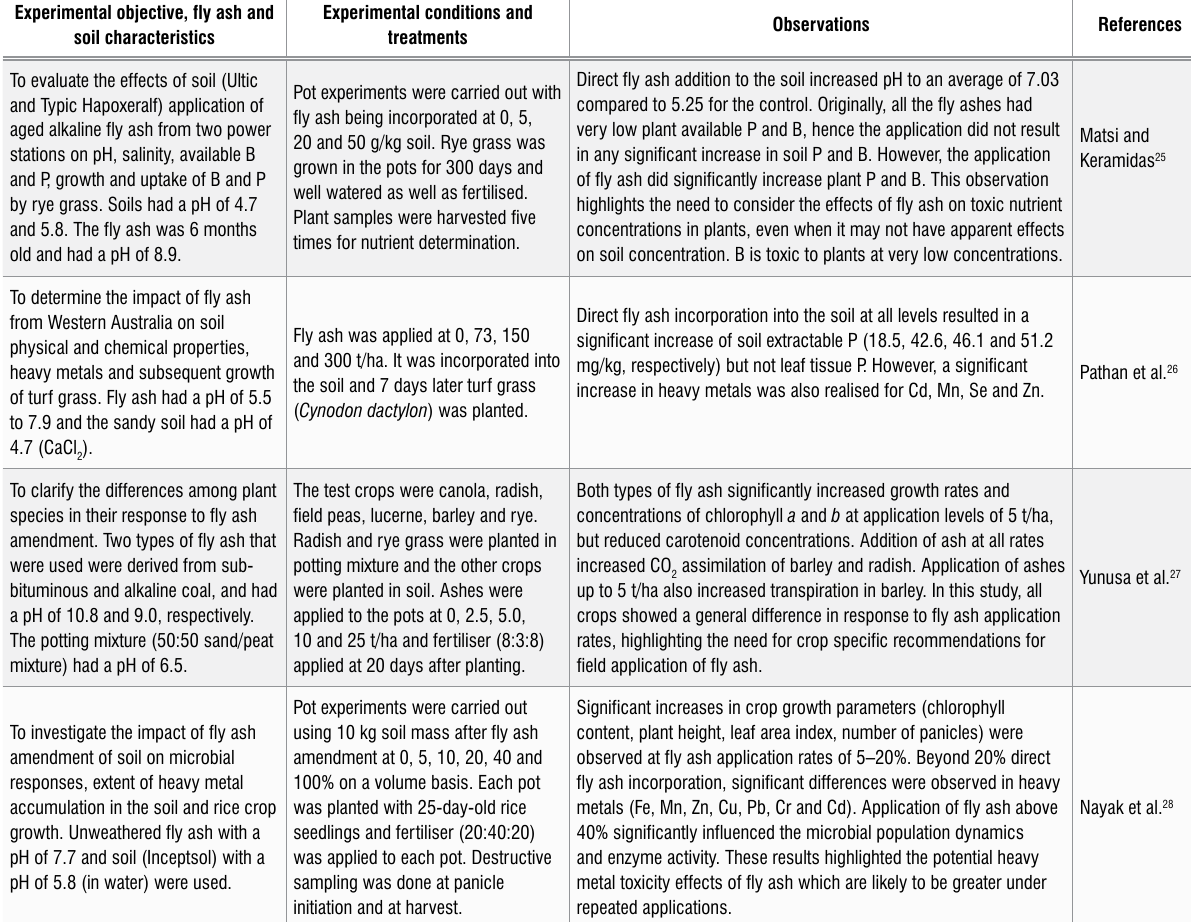
Some liming and crop nutrient supply effects from direct soil application of different fly ashes under various agricultural systems Experimental objective, fly ash and soil